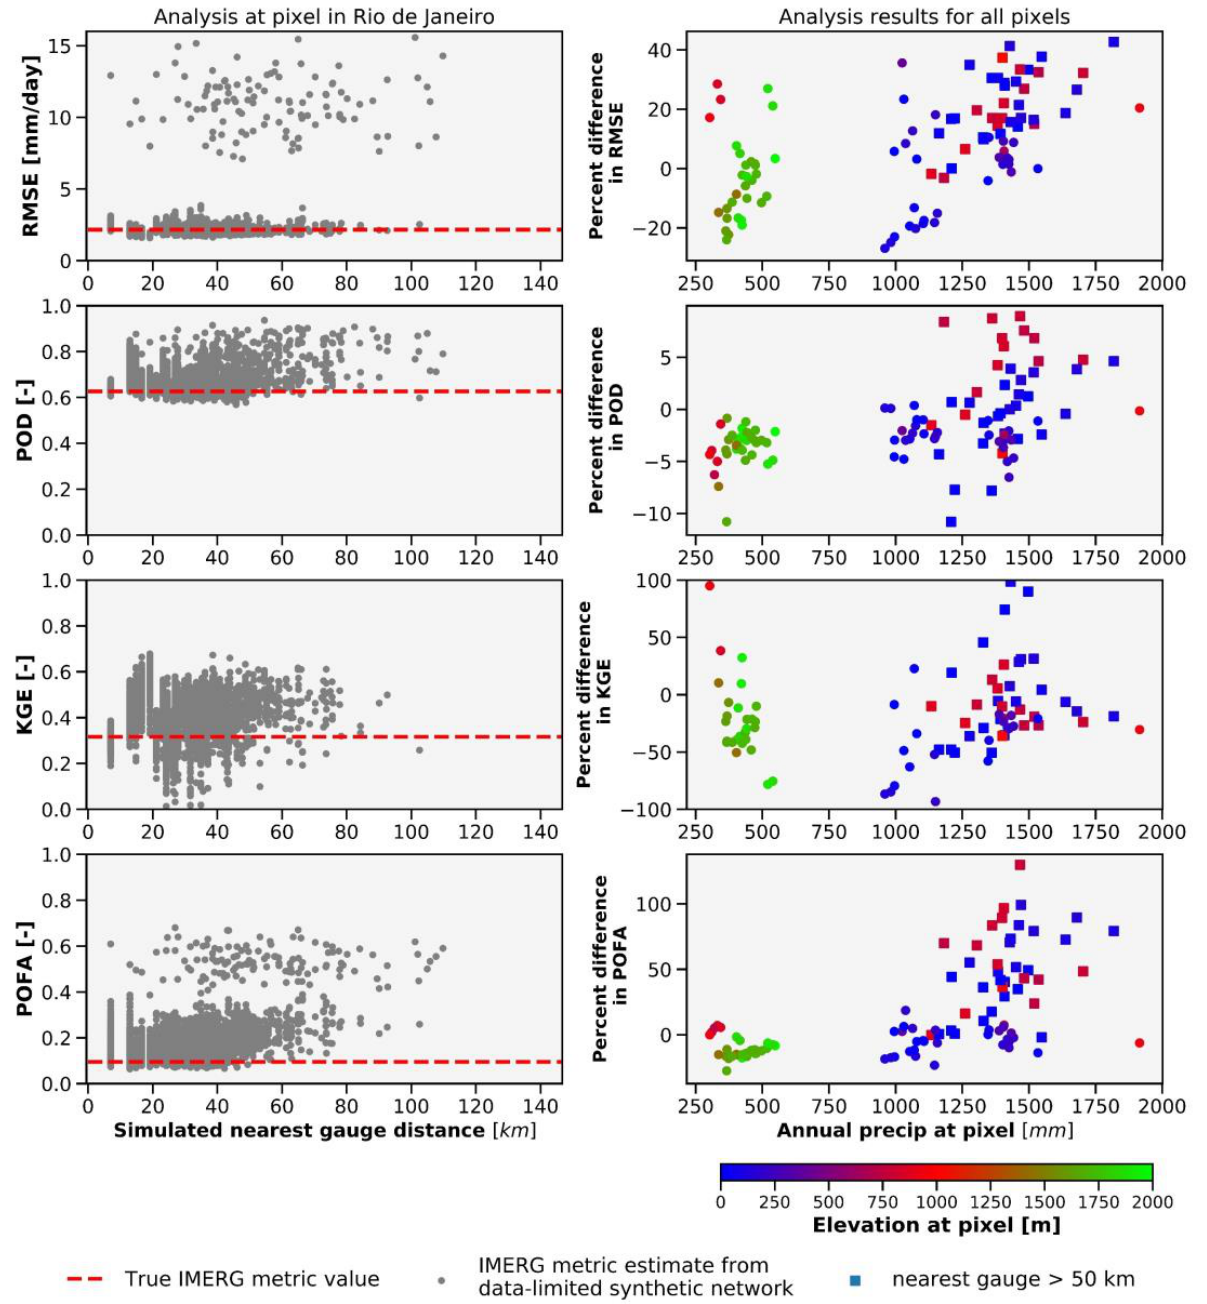
Figure 8. ( Left column ) Example of IMERG-Early RMSE, POD, KGE, and POFA assessed using data-limited simulations at a pixel in Rio de Janeiro. ( Right column ) Average percent difference between metrics estimated using data-limited interpolations with distance to nearest gauge greater than 50 km and the true IMERG metric. Positive percent difference values in right column indicate that data-limited interpolations are overestimating an error metric for IMERG.